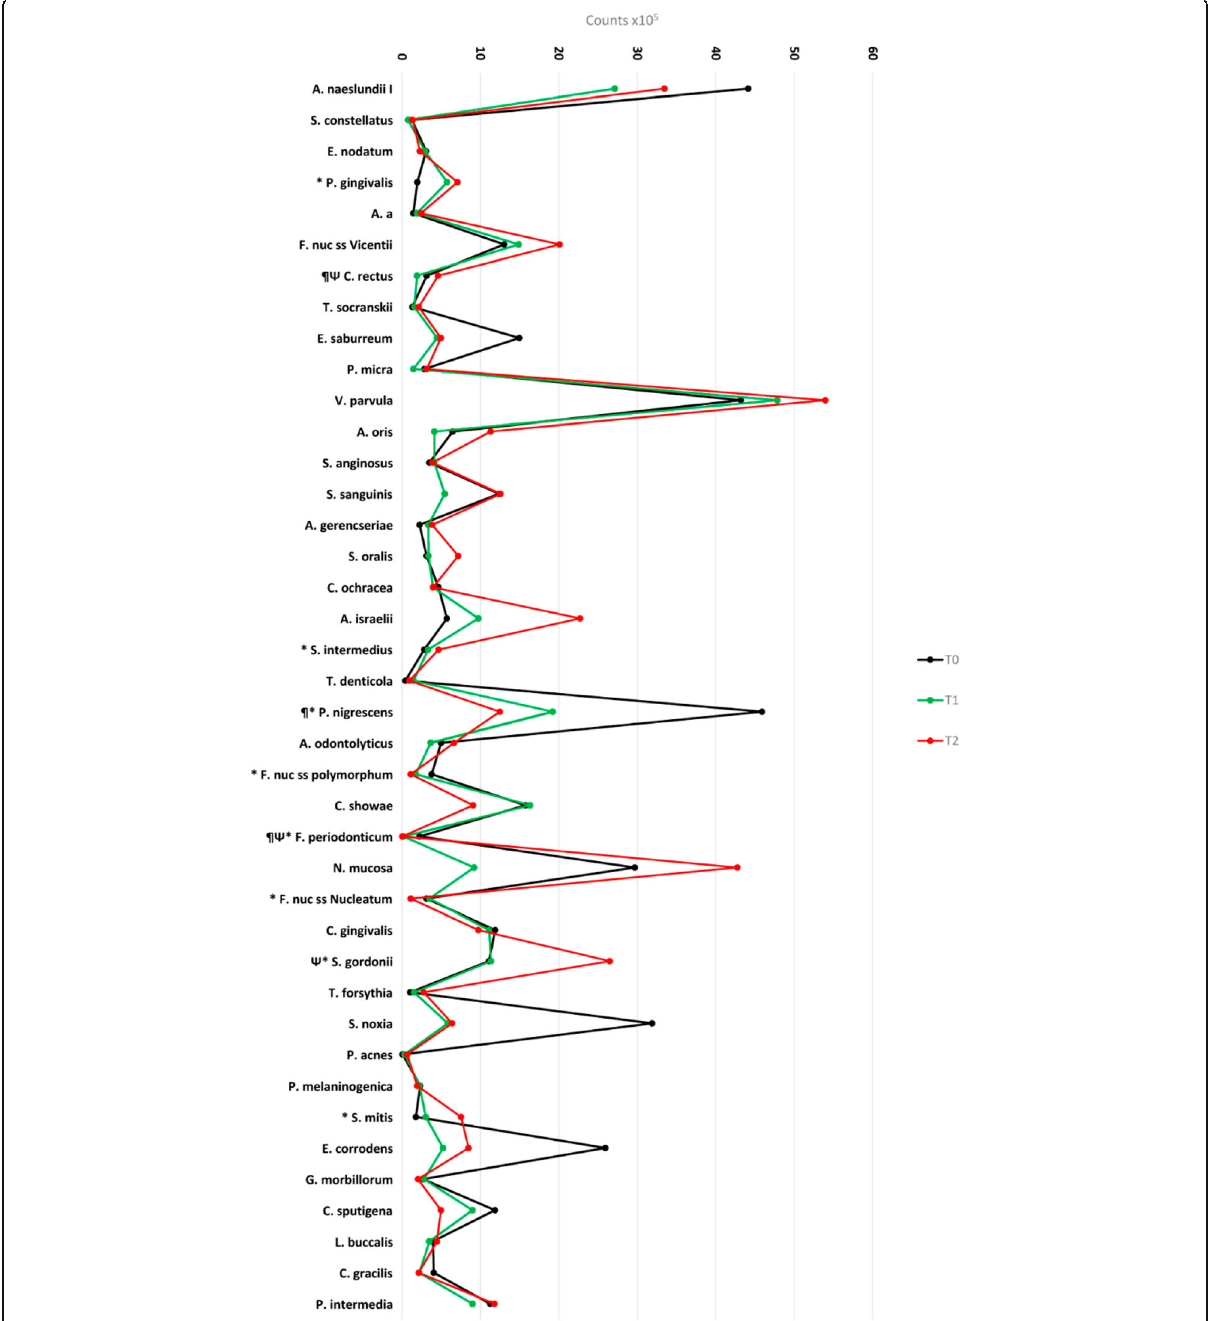
Fig. 2 Mean counts (× 10 5 ) of 40 bacterial species at T0, T1, and T2. Statistically significant differences: T1 (*) and T2 (¶) when compared with T0; ( Ψ ) between T1 and T2. Wilcoxon test ( p <